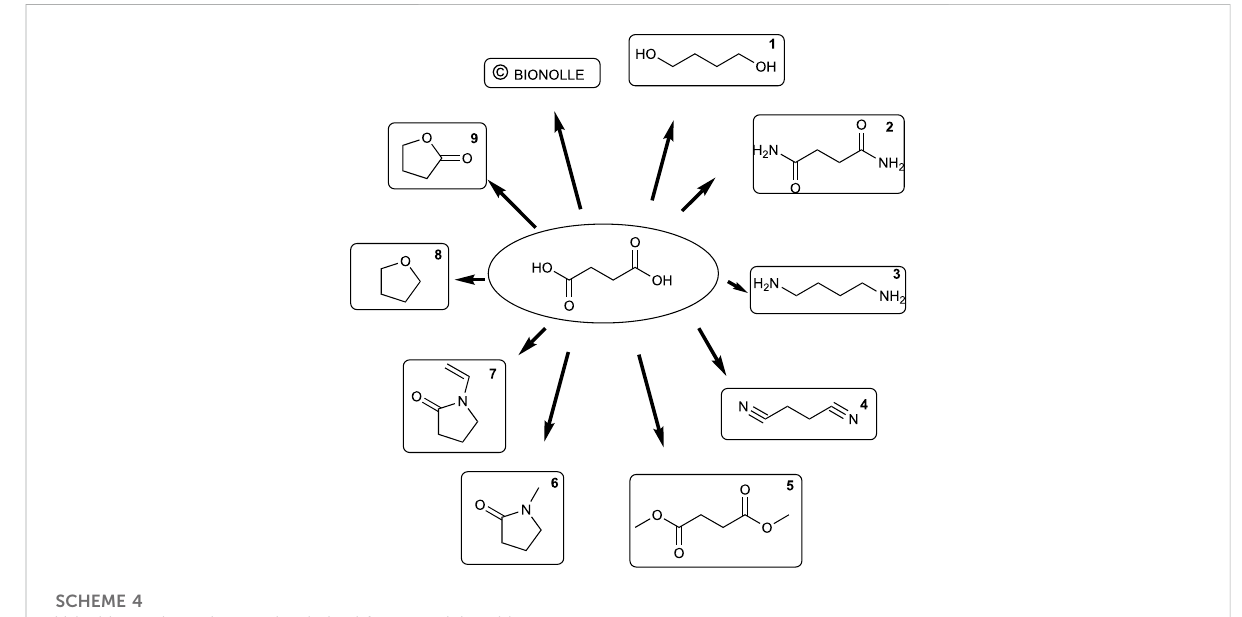
SCHEME 4 Valuable products that can be derived from succinic acid.